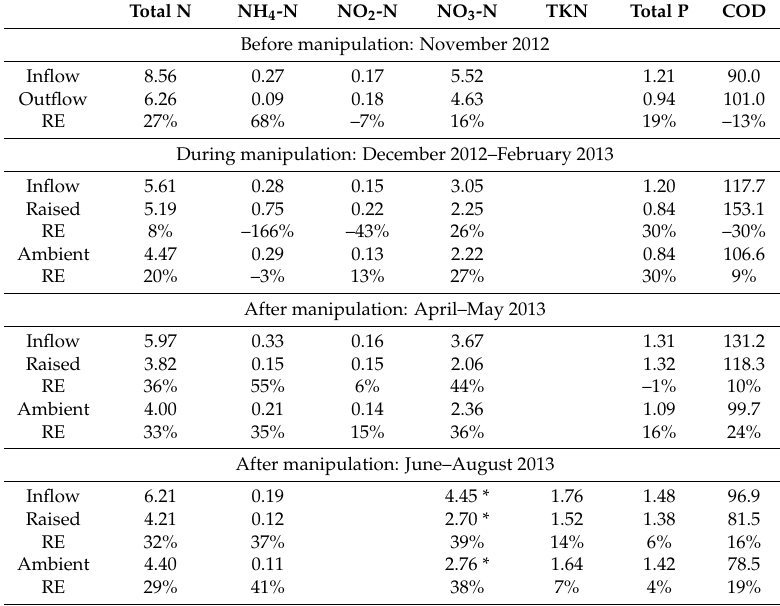
Table 2. Comparison of water quality parameters (mg · L − 1 ) in the inflow and outflow, and removal efficiencies (RE), of 0.09-ha test cells before, during and after hydroperiod treatments. Total